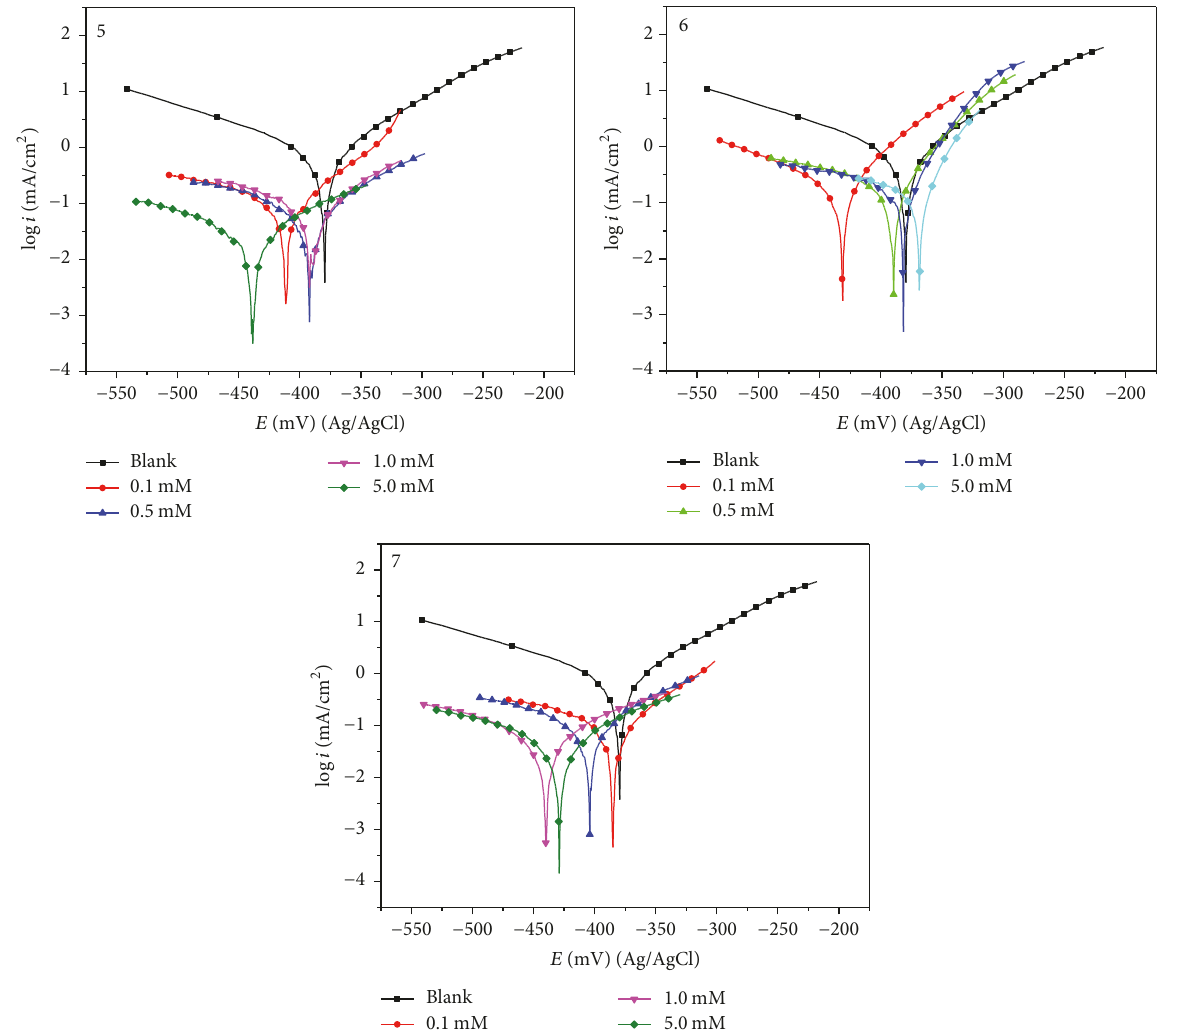
Figure 2: Polarization curves for steel in 1MHCl before and after adding different concentrations of Camphor thiosemicarbazone (5) , Carvone thiosemicarbazone (6) , and Pulegone thiosemicarbazone (7)